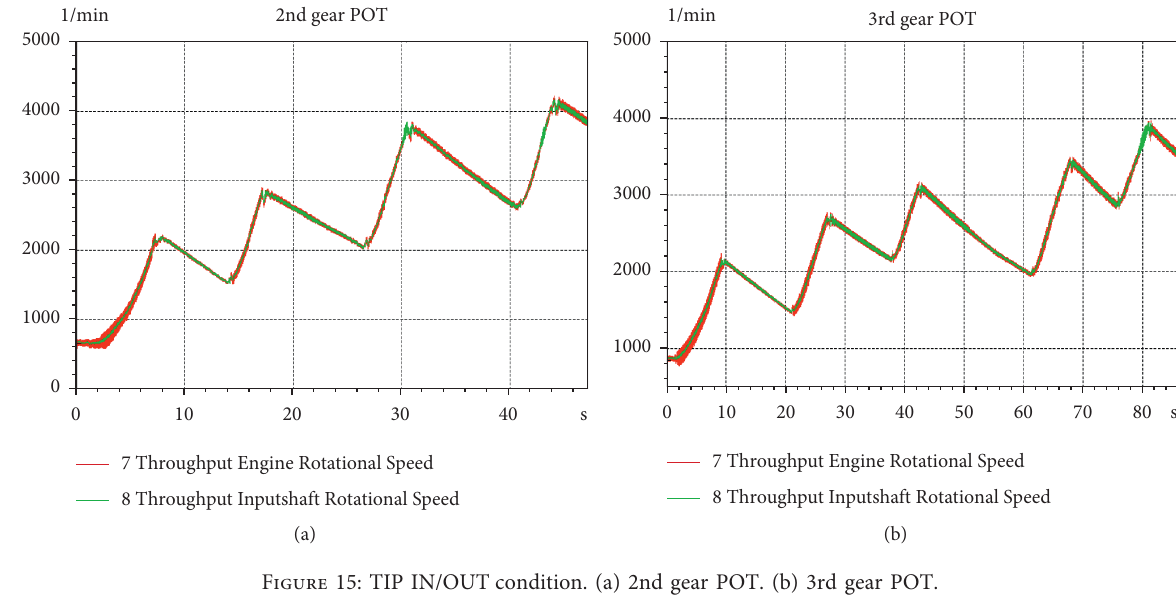
Figure 15: TIP IN/OUT condition. (a) 2nd gear POT. (b) 3rd gear POT.